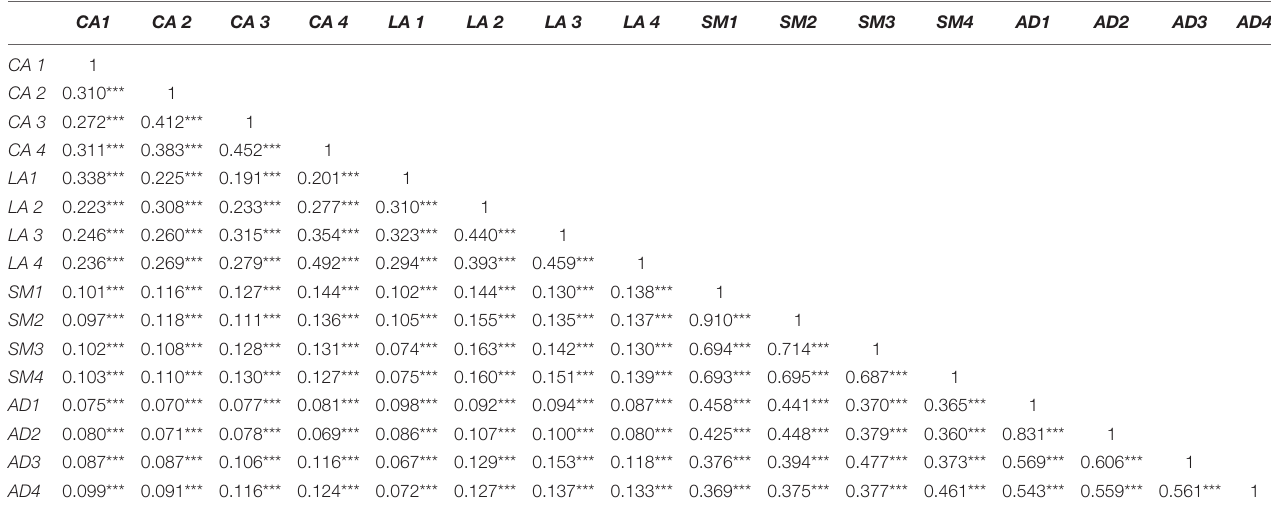
TABLE 2 | Correlation coefficient matrix.